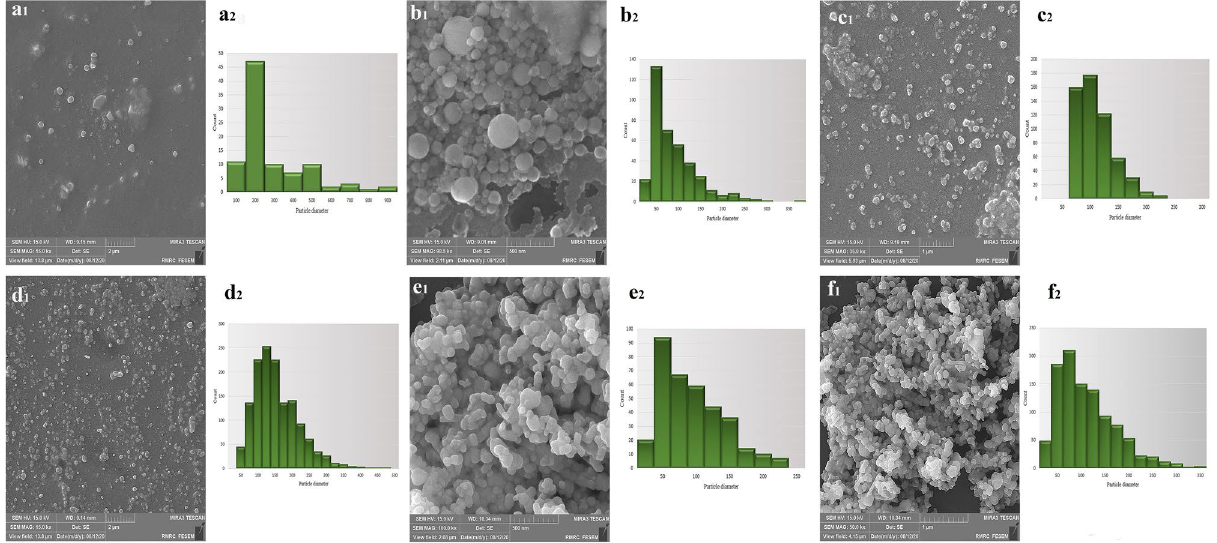
Figure 4. FESEM images of produced nanoparticles: ( a 1 –f 1 ) experiments 2, 3, 4, 6, 11 and 15 respectively. Corresponding particle size diagram: ( a 2 –f 2 ) experiments 2, 3, 4, 6, 11 and 15 respectively.